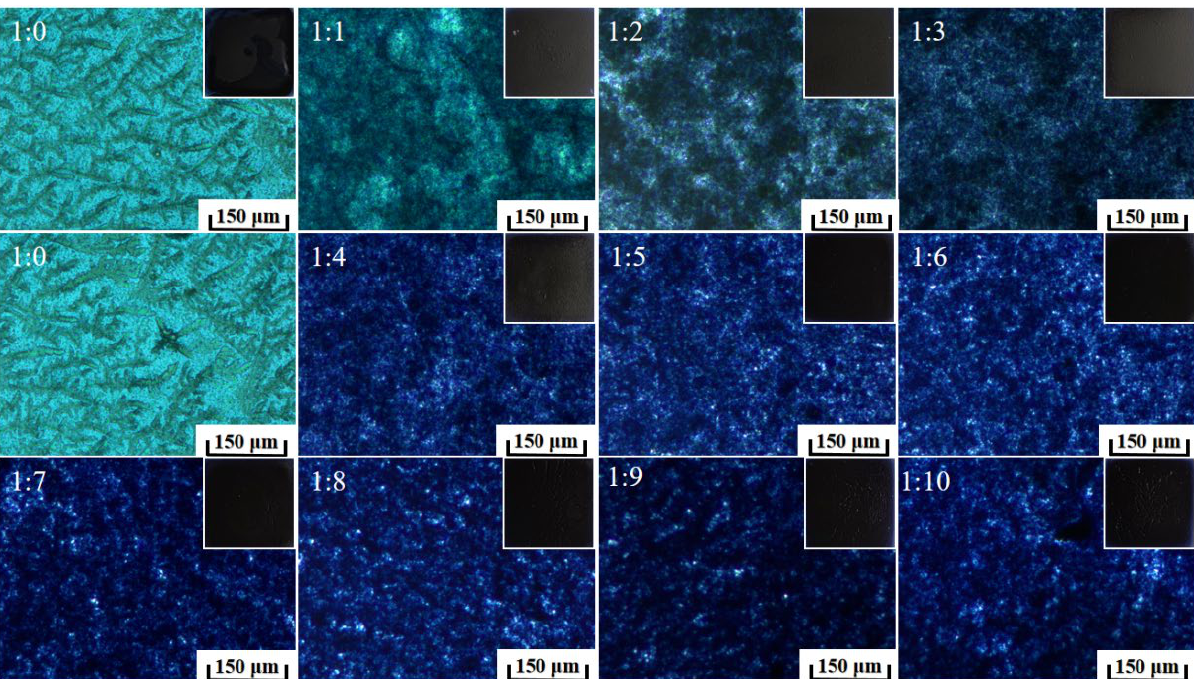
Figure 4. Microscope morphology photos of PEDOT:PSS/epoxy coatings (bottom light source) with different P:E ratios and their sample images.